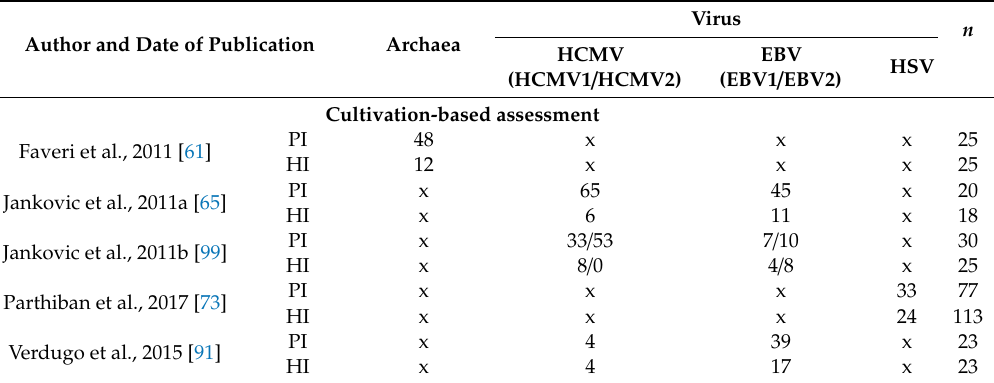
Table 8. Studies assessing archaea and